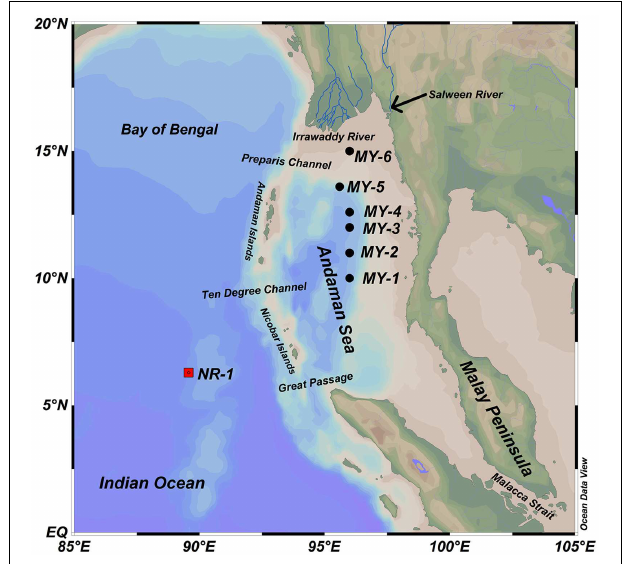
FIGURE 1 | Location of sampling stations in the northeastern Indian Ocean (NR-1, filled square) and the Andaman Sea (MY-1–MY-6, filled